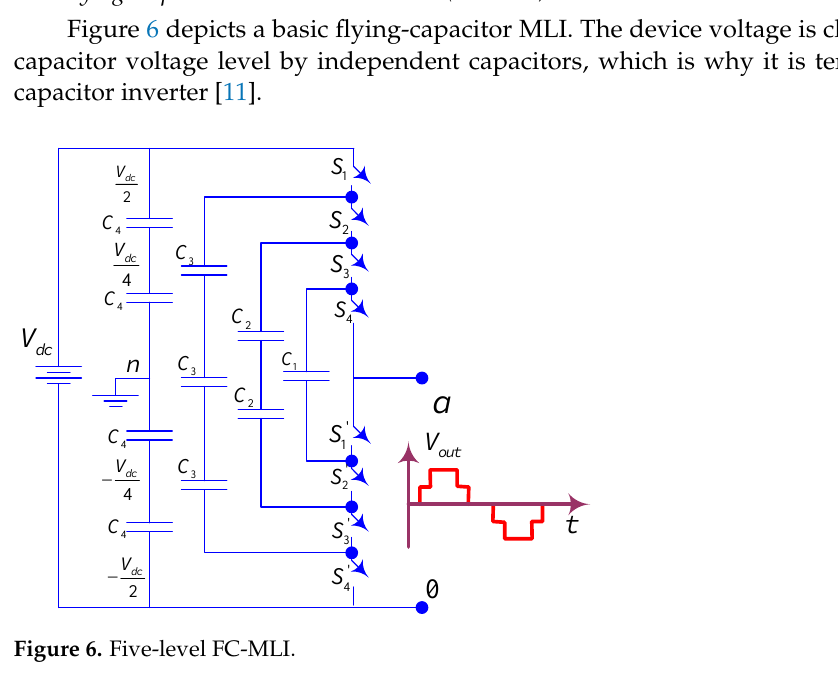
up in such a way that turning on one prevents the other from turning on. (S 1 , S 1 ′), (S 2 , S 2 ′),